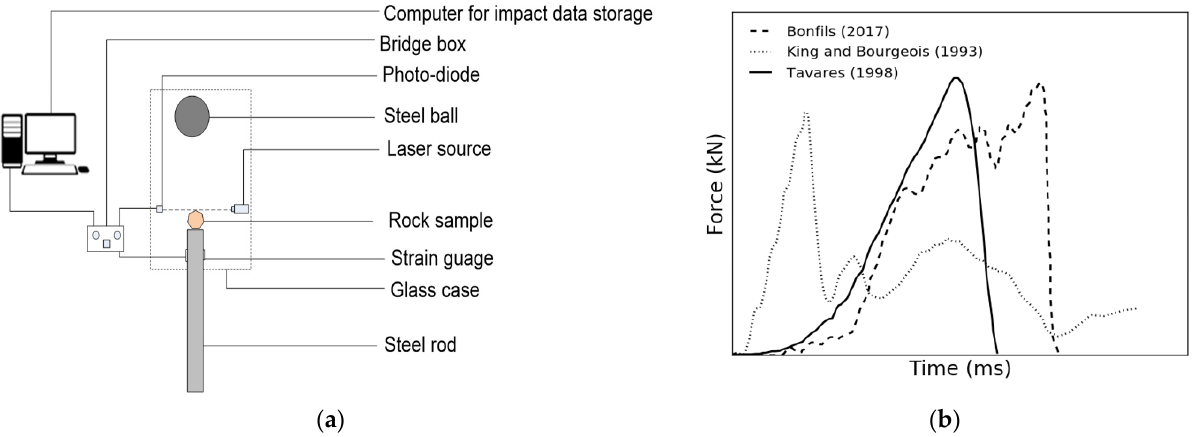
Figure 1. ( a ) A schematic of a SILC device [26] ( b ) Typical force-time profiles obtained in SILC experiments [24,27,28].